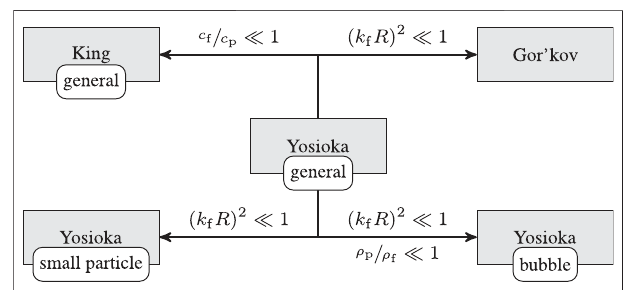
FIGURE 2 | Relationship between Yosioka and Kawasima ’ s general solutionand other theoriesand special cases. The rounded boxes indicate if a special case of a theory is assumed. The condition on the connection arrows indicate whenthe generalsolutionisequal totheothers. c p , ρ p and R are thesoundspeed,thedensity,and theradiusoftheparticle, respectively; c f , ρ f , and k f are the speed of sound, the density and the wavenumber in the fl uid,